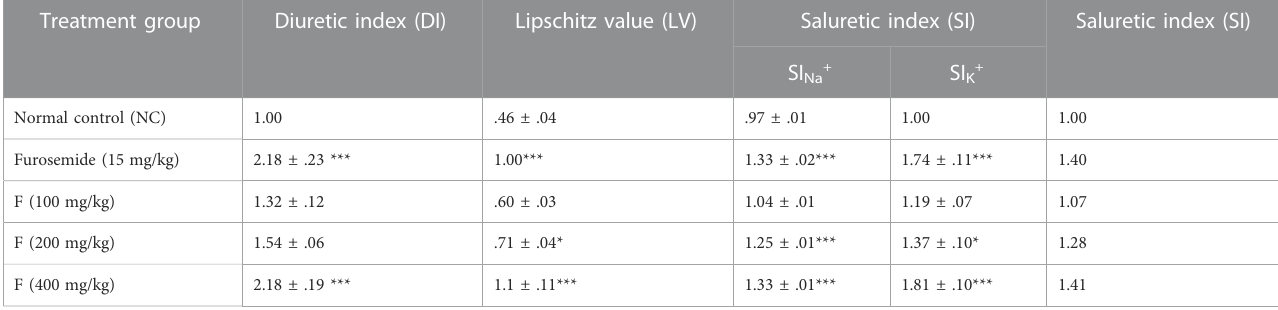
TABLE 7 Effect of fenchone on the diuretic index, Lipschitz value, saluretic index of Na + and K + , and saluretic index. Treatment